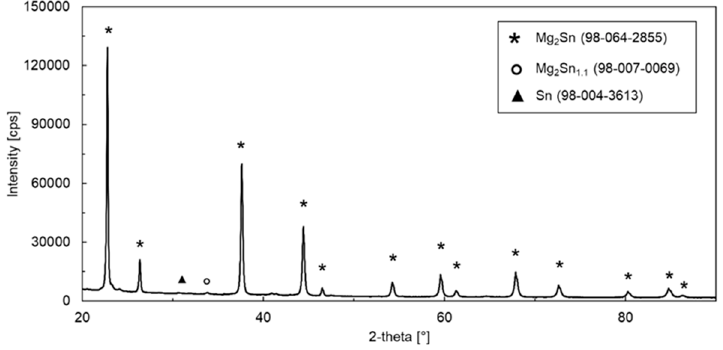
Table 3. Phases identified during the XRD analysis of the powdered Mg 2 Sn alloy.